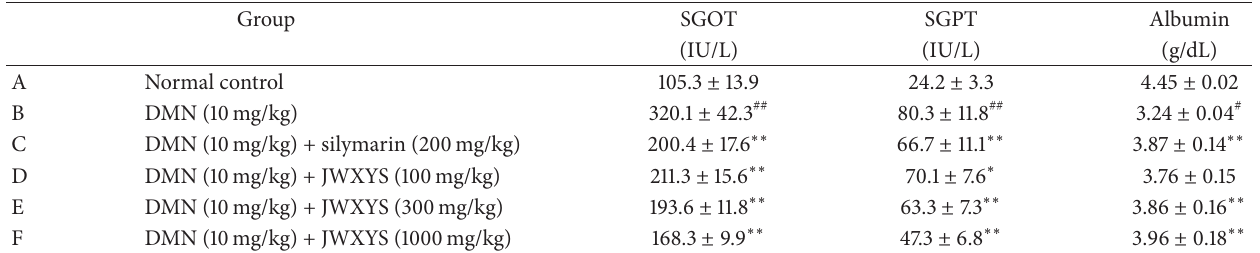
Table 2: Effects of JWXYS on the SGOT, SGPT, and albumin levels in rats with DMN-induced chronic liver injury. Group Normal control